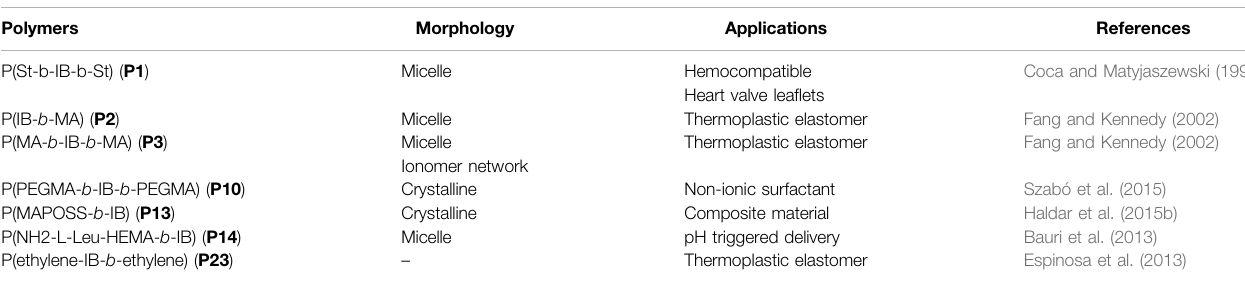
TABLE 1 | Polymers, their morphologies, and applications. Polymers